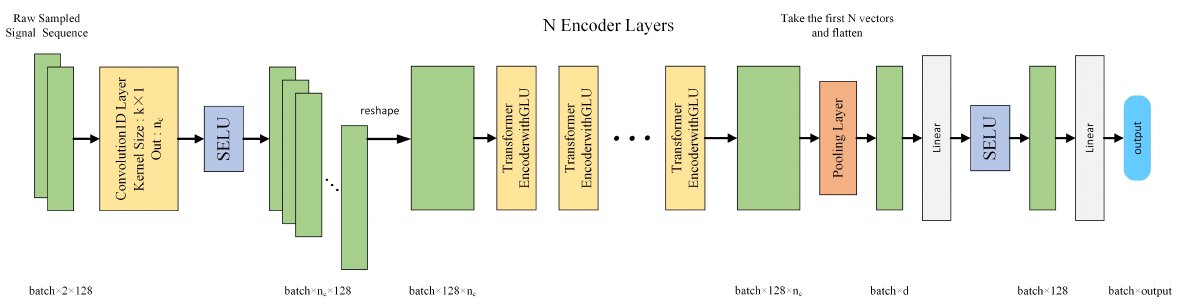
Figure 7. Transformer-based automatic modulation recognition network improved by gate linear